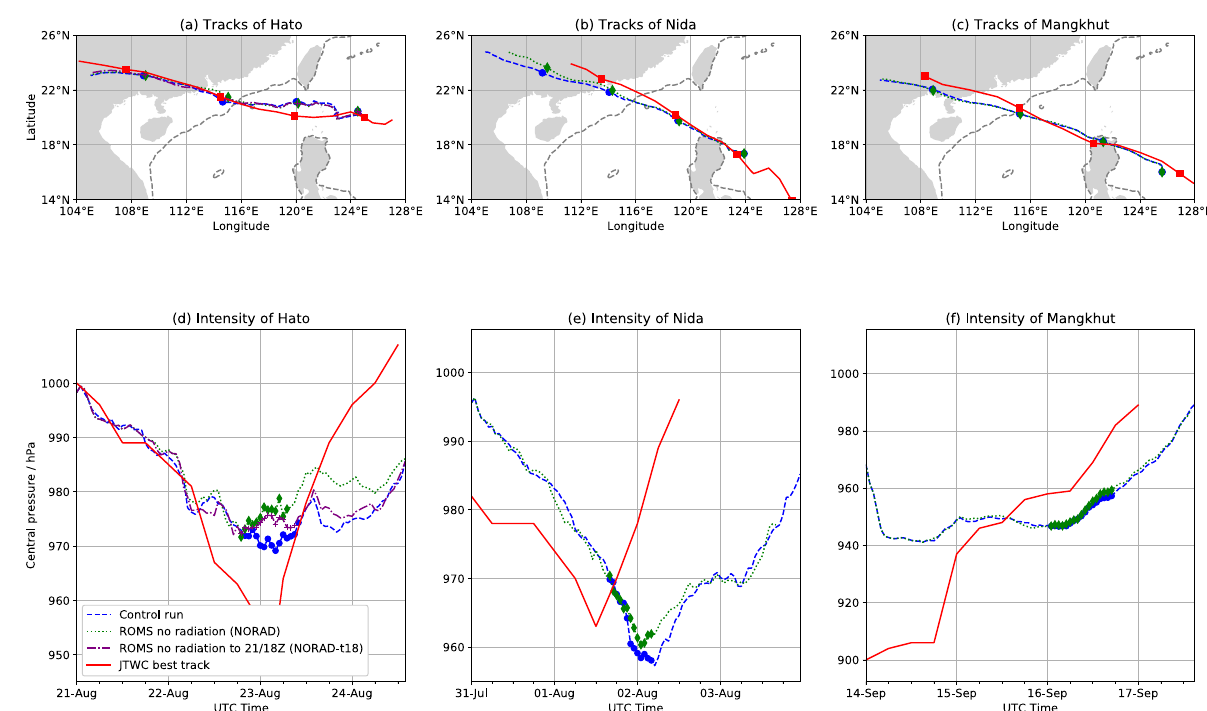
Fig. 1 Simulated tracks and intensities of TCs. Tracks of Typhoons a Hato, b Nida, and c Mangkhut from the JTWC best track (red solid), the control (blue dashed), the NORAD (green dotted) and NORAD-t18 (purple dash-dotted) experiments. Their positions at 00 UTC are marked by squares (JTWC), circles (control), diamonds (NORAD) and crosses (NORAD-t18) respectively. Ocean isobaths of 200 m are drawn in gray dashes. Time series of minimum sea- level pressure in hPa of d Hato, e Nida and f Mangkhut, with markers indicating their passages over the continental